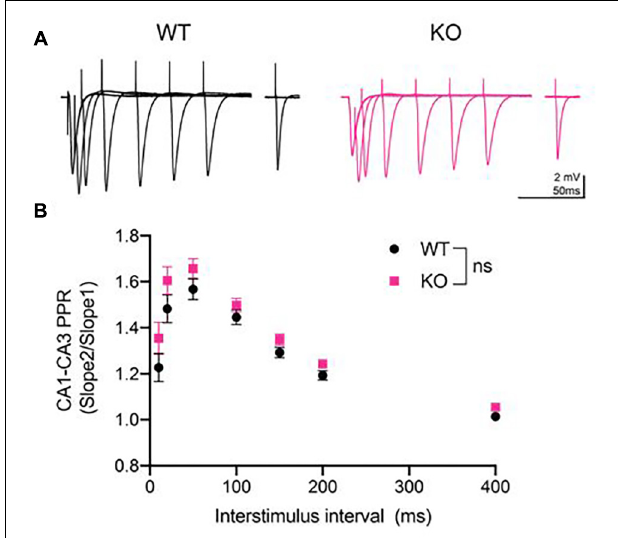
FIGURE 2 | Paired-pulse ratio (PPR) was unaltered at CA3-CA1 synapses in PINK1 KO rats compared to WT littermate controls. (A) Representative fEPSP traces from 4 months WT (black) and PINK1 KO (Pink) rats. (B) After a 10 min stable baseline, pairs of stimulation were delivered at 10, 20, 50, 150, 200, and 400 milliseconds (ms) inter-stimulus intervals (ISIs). PPR was calculated by dividing the initial slope of the first event. Repeated measures two-way ANOVA showed no statistical differences [ p > 0.05, F ( 1 , 54 ) = 2.418] between WT ( n = 26 slices/11 animals) and PINK1 KO rats ( n = 26 slices/11 animals).